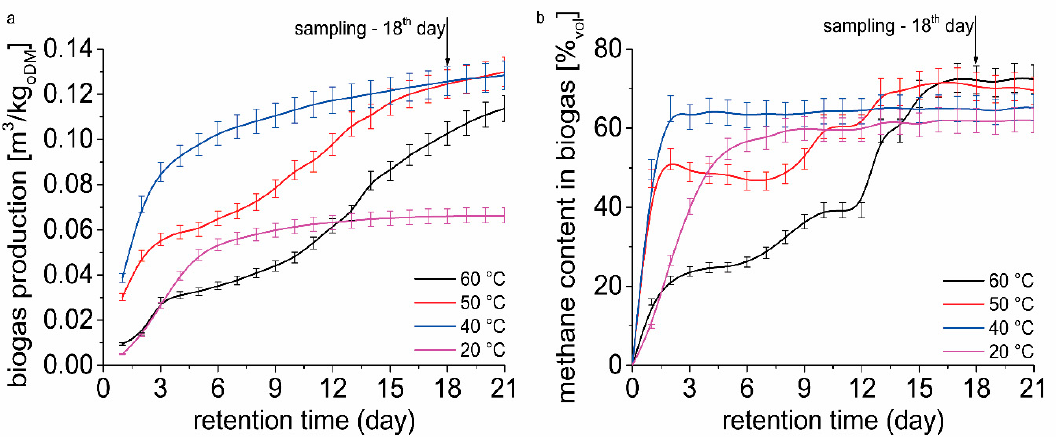
Figure 3. Biogas cumulative production ( a ) and methane content in biogas ( b ).